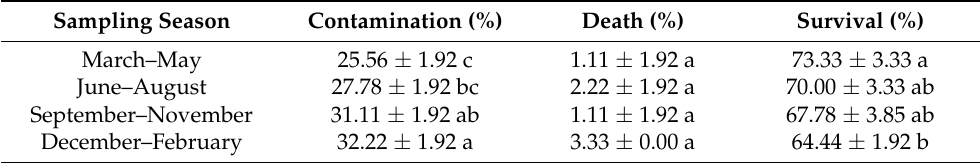
Table 4. Effect of sampling season on explant sterilization.